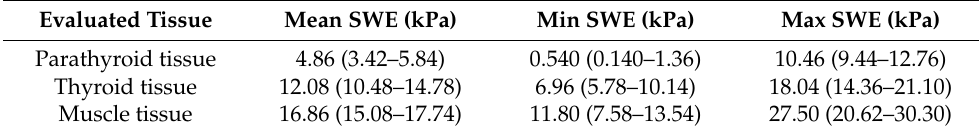
Table 3. Results of the first lot of primary hyperparathyroidism.